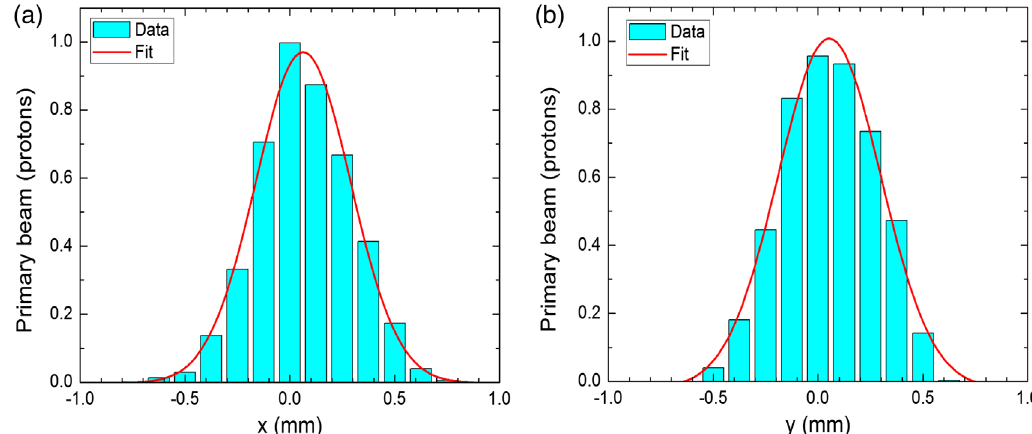
FIG. 3. Measured profile of the incoming primary proton beam just upstream of the production target (a) horizontal beam profile and (b) vertical beam profile. The histograms are raw data at the TARGET-SEM, while the red curve is a Gaussian fit. The fit to the data ¼ 0 . 22 mm and σ ¼ 0 . 24 reveals that the beam spot size at the target is σ x y